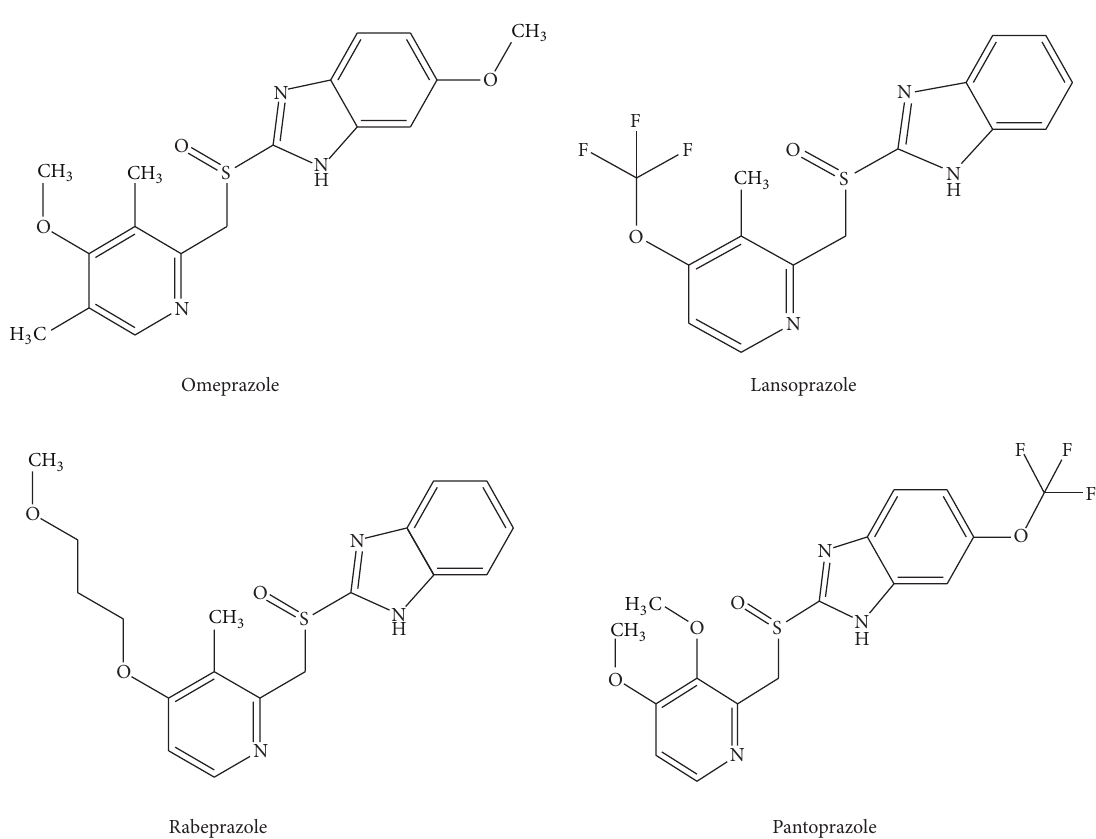
Figure 1: Licensed compounds available in the market to treat the hyperacidity and GERD.